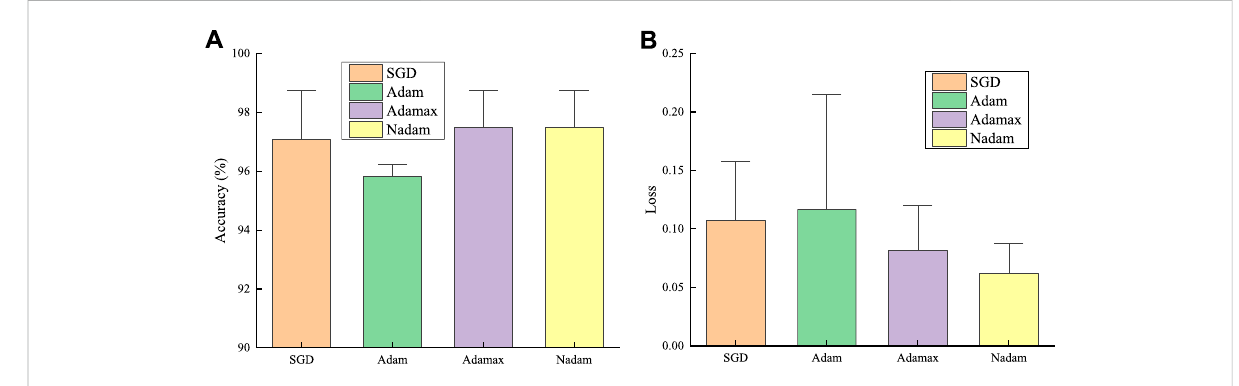
FIGURE 6 Results of the 1D-CNN-B network under different optimizers. (A) Accuracy and (B) loss.